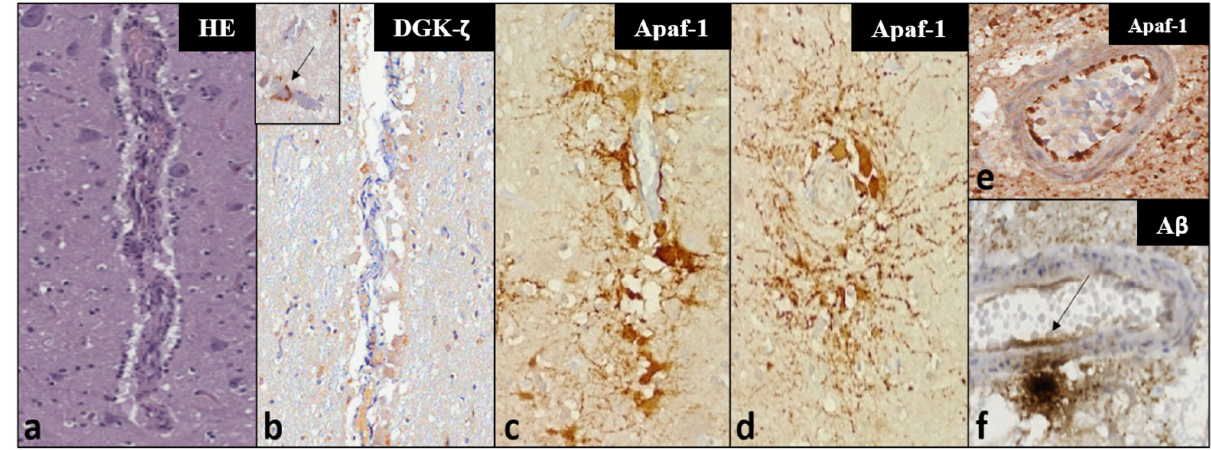
Fig 4. Histochemical (a) and IHC (b-f) findings in vascular and perivascular tissues in the investigated dolphins—Magnification: 100x. Panels a-c represent the same vessel in consecutive sections. (a) Microscopic appearance of a mid-caliber vessel in the IC of ID344 using a haematoxylin-eosin staining, with a mild perivascular infiltrate characterized by mononuclear inflammatory cells. (b) very mild cytoplasmic DGK- z -IR in few foci of perivascular glia. Inset: Moderate, multifocal IR in pericapillary neuropil of ID133 (arrow)—magnification: 200x. (c) The same vessel of ID344 displays intense Apaf-1-IR, mostly in the cytoplasm of pericytes, showing perivascular distribution and radiating cellular processes, visible also in transverse sections of the IC vessels of ID344 (d). (e) Clearly demarcated endothelial Apaf-1-IR in a VCN vessel of ID142. (f) A β -IR deposit in neuropil adjacent to a mid-caliber VCN vessel—the IR appears to extend into the vessel wall and endothelial lining (arrow).